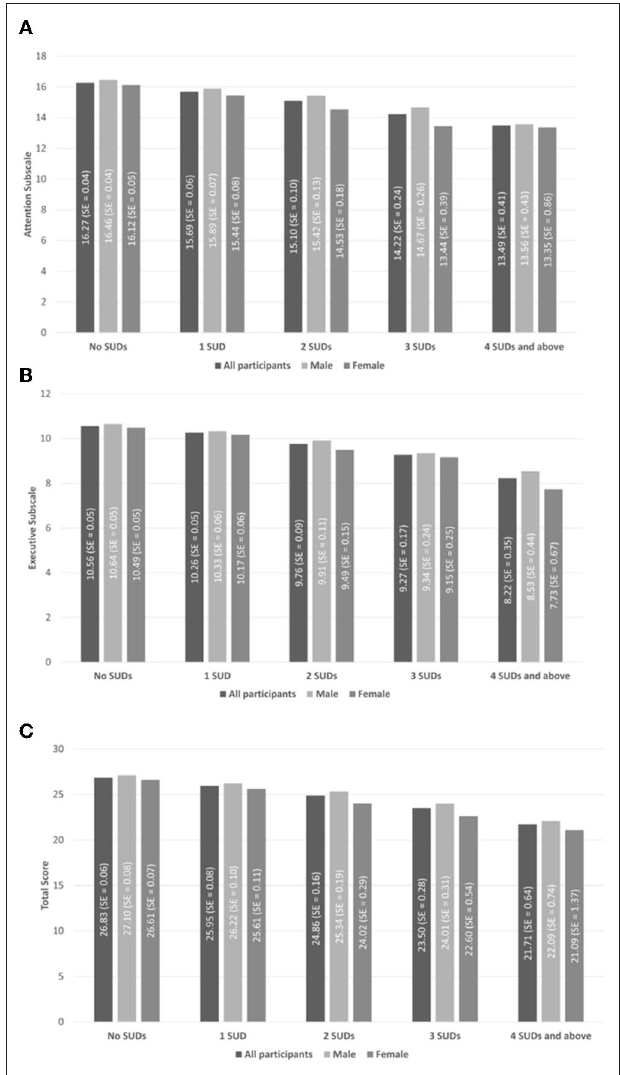
FIGURE 1 | Estimated marginal means of executive function index (EFI) scores and respective standard error (SE) (means and SE adjusted for all above mentioned sociodemographic controls except sex) for males, females, and all participants by number of substance use disorders (SUDs). (A) The attention subscale (maximal score = 20). (B) The executive function subscale (maximal score = 16). (C) The total score (maximal score = 46). Values presented here were adjusted using NESARC-III Survey weights but not for